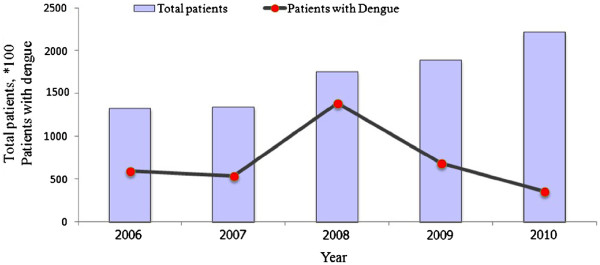
Changes in temperature, rainfall and humidity from January to December, 2009. The X-axis shows the monthly average climatic variation, while the Y-axis shows climatic factor ranges such as temperature, humidity and rainfall. Humidity and temperature remained the same throughout the year but rainfall varied. Normally in Phitsanulok the rainy season starts from April and ends in October.